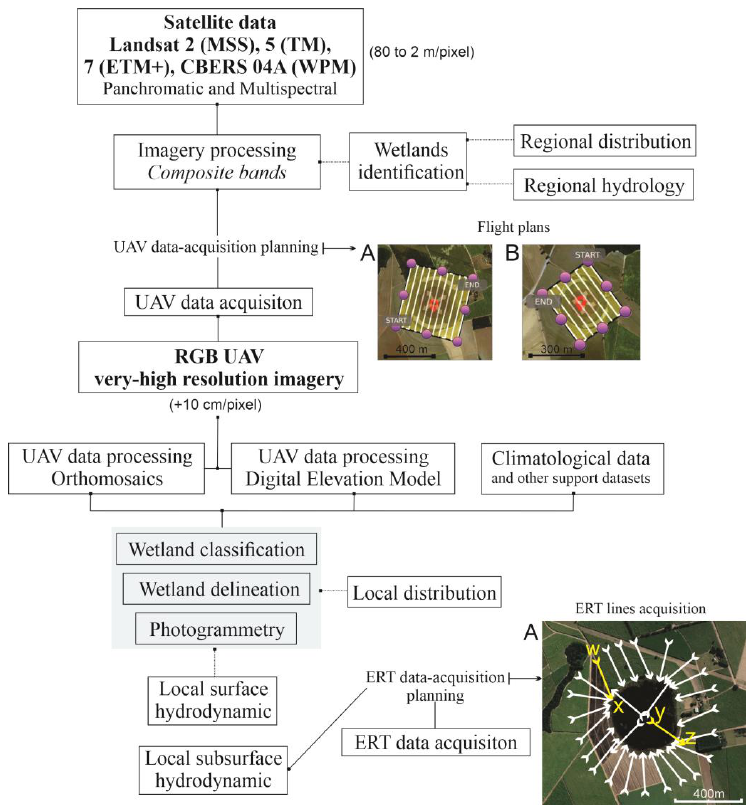
Figure 2. Multi-scale process used during the development of the different stages of the study, incorporating satellites, UAV, and Electrical Resistivity Tomography workflows and applications during the study.